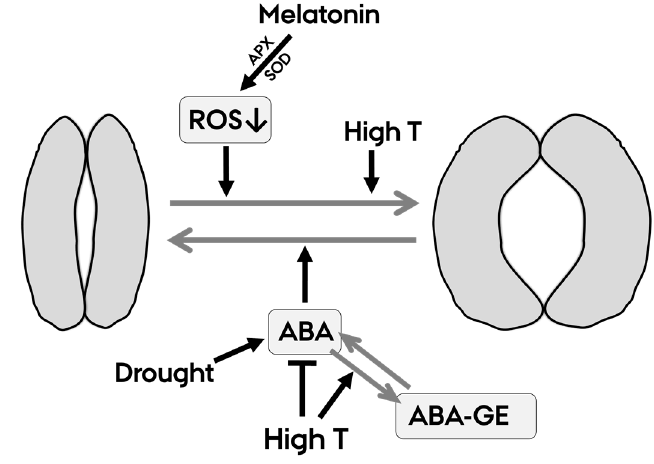
Figure 5. Graphic summary of the proposed mechanisms interacting in stomatal regulation by melatonin, heat and drought at combined stress. Upper part of figure: stomatal opening is promoted separately by both heat effects of stomata and by inhibition of ROS signaling in stomatal closing induced by melatonin. Lower part: stomatal closing is promoted by an ABA accumulation as response to drought. Our results suggest that heat counteracts the accumulation of ABA by increasing the conjugation to ABA-GE and through additional effects on either transport, synthesis or breakdown.